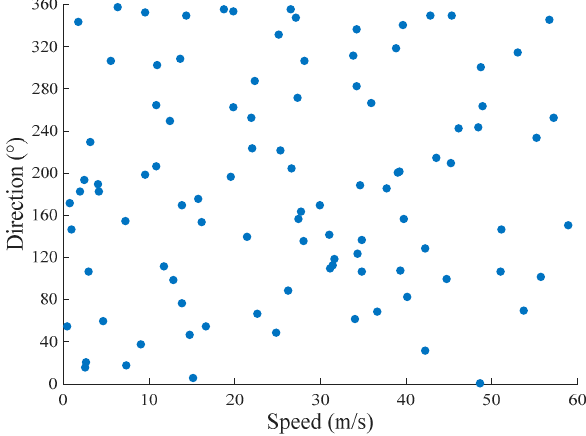
Figure 7. One-hundred groups of simulated wind speed and direction data.